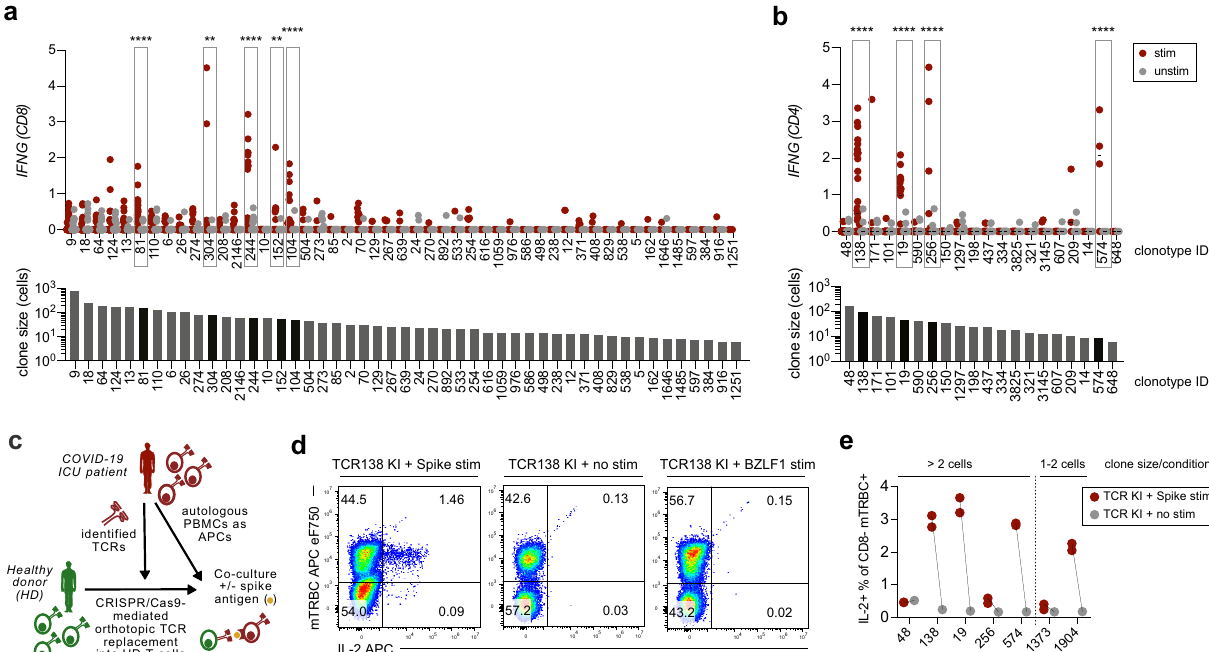
Fig. 2 Identi fi cation and validation of SARS-CoV-2 antigen-reactive T cell receptors. a Top: IFNG expression of CD8 clonotypes after antigenic or no stimulation. Only clonotypes with at least three cells in each condition and as de fi ned by a unique αβ CDR3 sequence were included in this analysis. Each dot represents one cell and lines indicate the median. n = 56/66 (clone 81), 38/30 (clone 304), 25/30 (clone 244), 16/16 (clone 152), and 23/22 (clone 104) cells for stim/unstim condition, respectively. Exact cell numbers per clonotype can be found in Supplementary Data 11. Antigen-reactive clonotypes (de fi ned through statistically signi fi cant upregulation of IFNG ) are highlighted. p < 0.0001 for clones 81, 244, and 104; p = 0.0033 for clone 304. Bottom: Clonotype sizes in numbers of total cells analyzed. Clonotypes de fi ned as “ reactive ” are highlighted in black. b As in a, but for CD4 clonotypes. n = 28/42 (clone 138), 17/26 (clone 19), 11/18 (clone 256), and 4/4 (clone 574) cells for stim/unstim condition, respectively. p < 0.0001 for clones 138, 19, 256, and 574 c Experimental setup; T cells from healthy donors were equipped with TCRs identi fi ed from COVID-19 patients by CRISPR/Cas9-mediated orthotopic TCR replacement (OTR); transgenic T cells were co-incubated with antigen-loaded patient PBMCs and reactivity was investigated by intracellular cytokine staining. d Flow-cytometric analysis of antigen-stimulated TCR-engineered T cells, 1 week after OTR; representative data are shown for CD4 TCR138 after stimulation with SARS-CoV-2 spike protein – peptide mix, no stimulation, and stimulation with irrelevant EBV antigen BZLF1 peptide mix (negative controls); mTRBC: murine constant region of the TCR beta chain incorporated into transgenic TCRs for detection; shown gates are pre-gated for CD3 + CD8 − living lymphocytes. e Quanti fi cation of spike antigen-speci fi c reactivity for selected clonotypes tested in ( b ) as well as two additional small clonotypes; for antigen-speci fi c transcriptional shifts detected by initial scRNA seq for the respective clones see Fig. 1e, Supplementary Fig. 5a and Supplementary Fig. 7b. n = 1 technical replicate (no stim) and n = 2 technical replicates (stim). Statistical analysis by two-way ANOVA (**** each for the treatment effect and clonotype distribution) followed by Sidak ’ s multiple comparisons test * p < 0.05, ** p < 0.01, *** p < 0.001, **** p < 0.0001 ( a , b ). Data are shown for patient